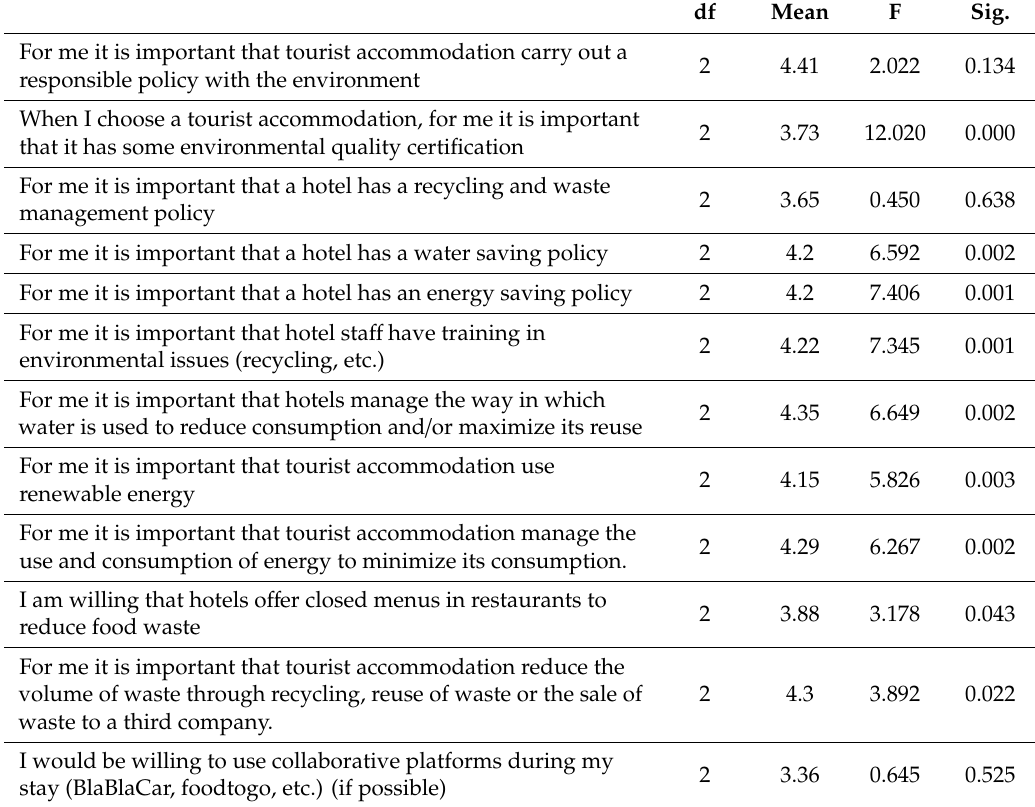
Table 5. ANOVA test comparing attitude towards circular practices by age groups.